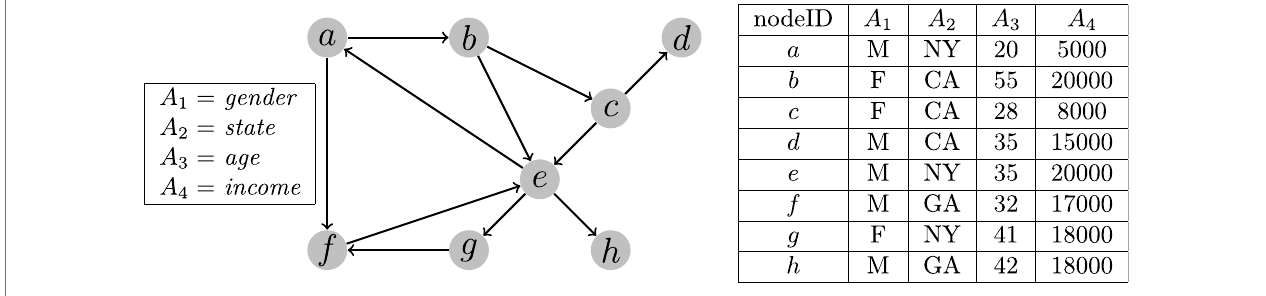
FIGURE 2 | An example of network with